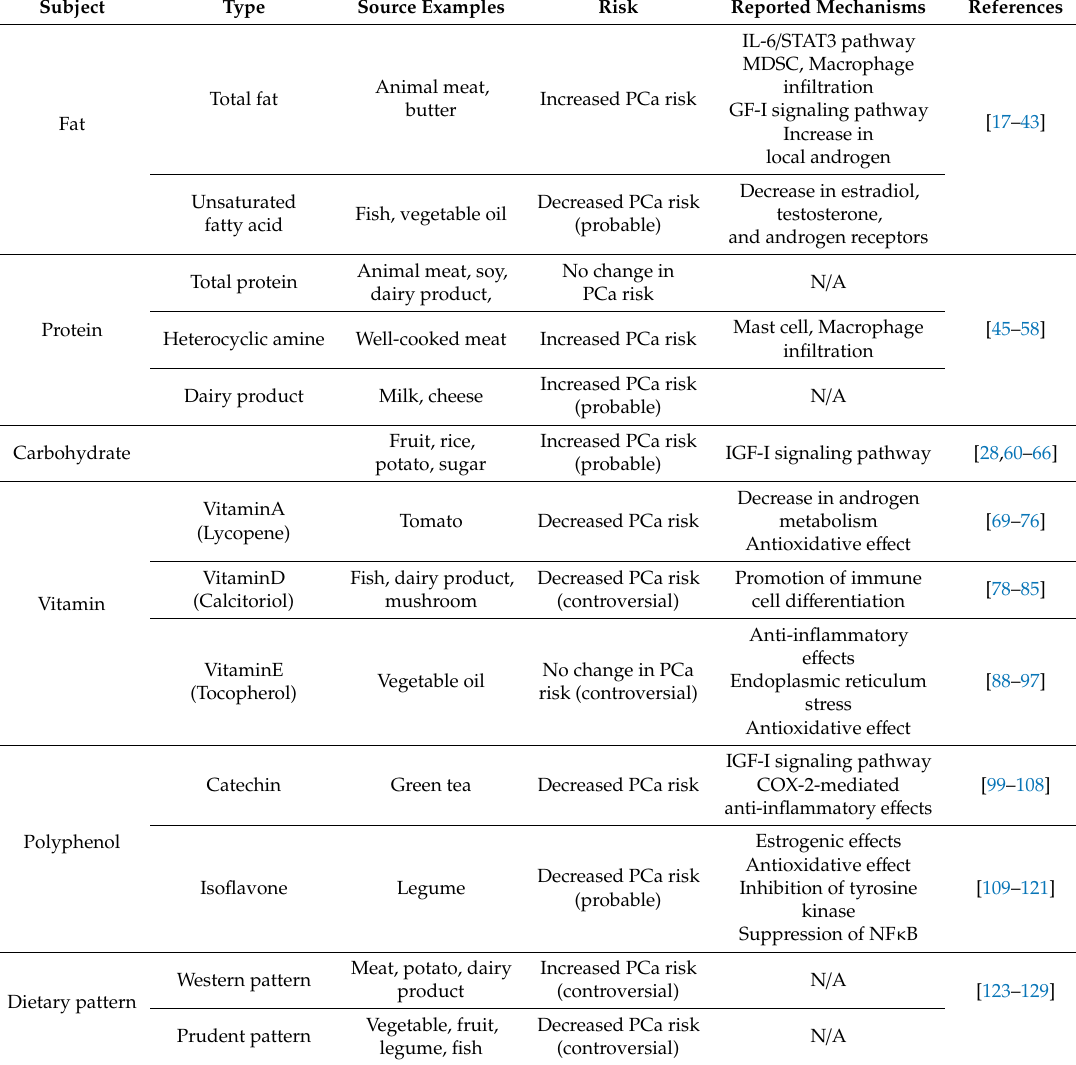
Table 1. Summary of nutrients, dietary patterns, and evidence for their association with prostate